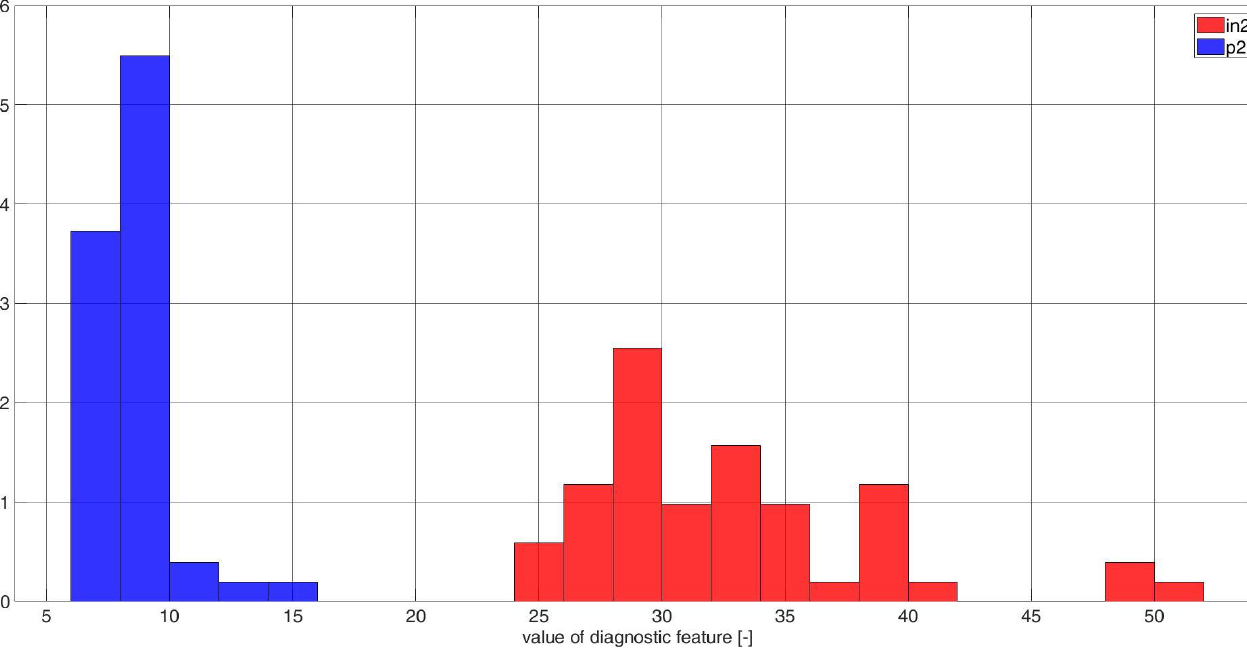
Figure A26. Histograms of diagnostic features based on the CCSM3 (correlation number is 28— Table A1) bearings in2 and p2. Table A1) bearings in2 and Table A2. List of spectral components, used for outer race diagnosis.